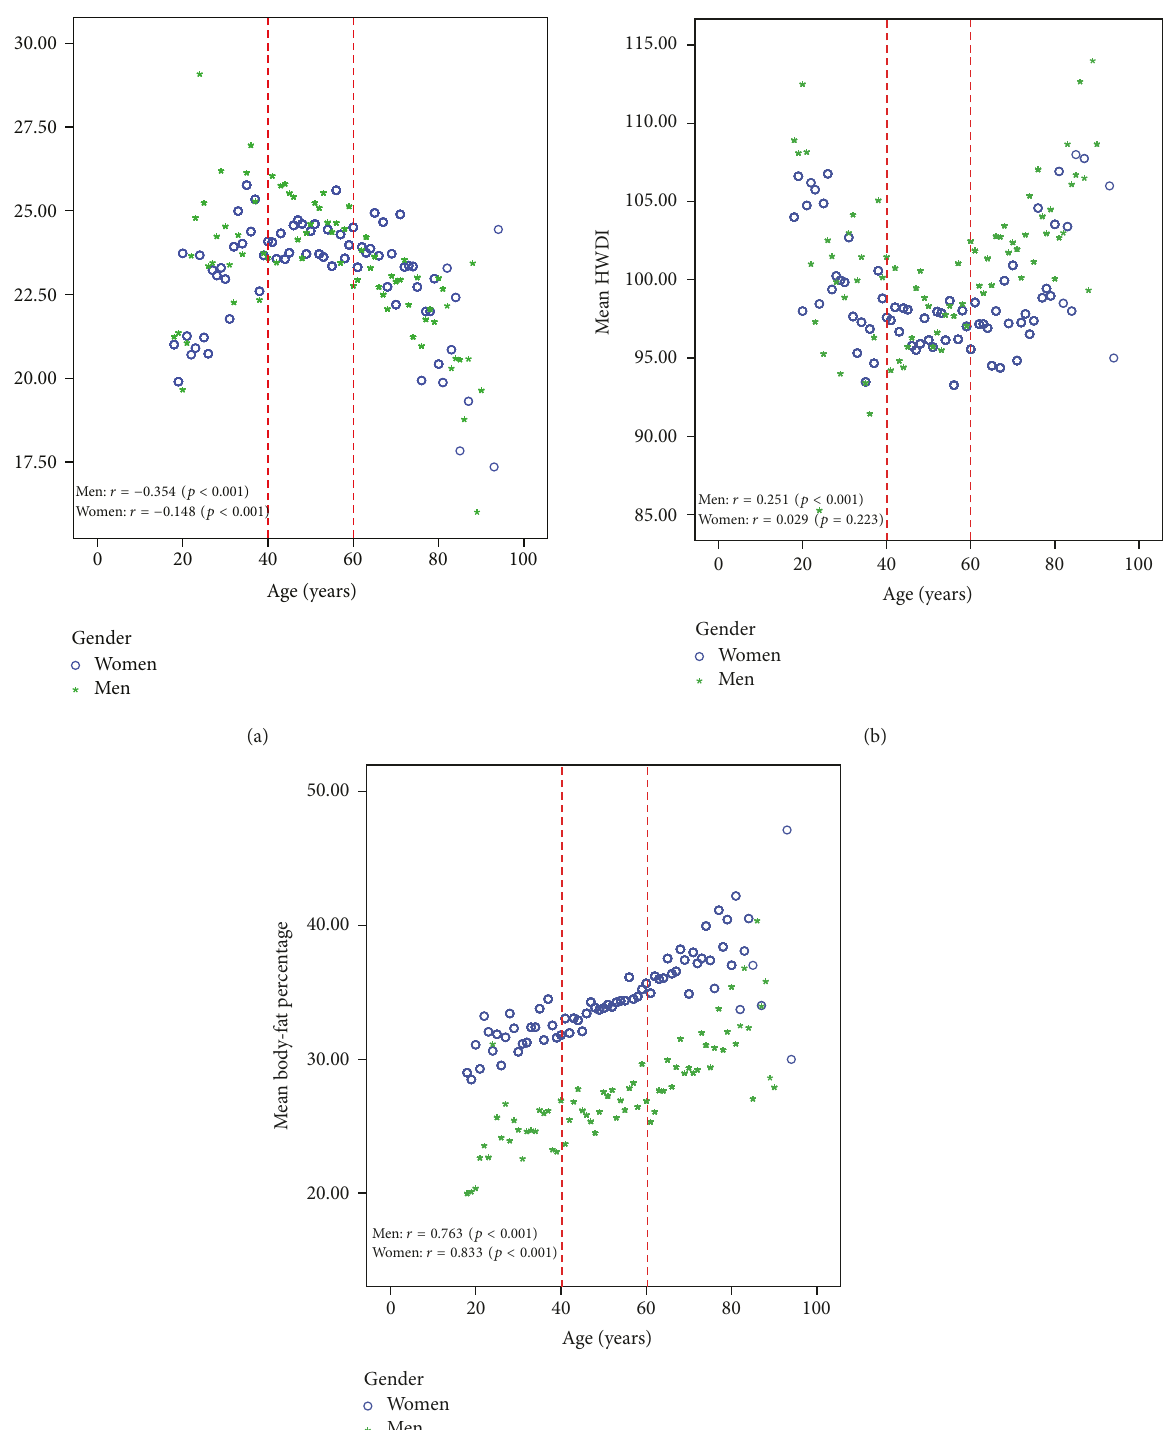
Figure 1: Relationship between (a) mean BMI and age, (b) mean HWDI and age, and (c) mean body-fat percentage and age, stratified by gender, ( I ) for women and (*) for